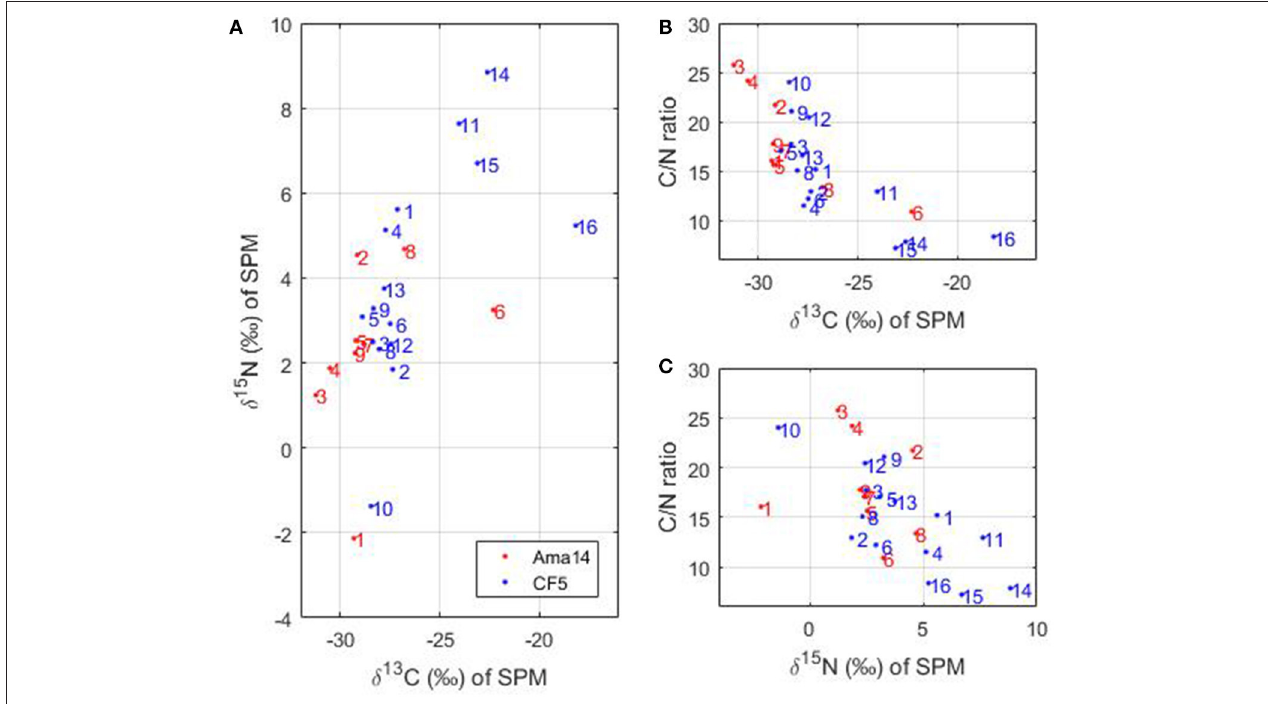
FIGURE 8 | (A) δ 15 N as a function of δ 13 C, (B) C/N ratio as a function of δ 13 C and (C) C/N ratio as a function of δ 15 N measured during the transect in May 2014 (in red) and the Camadas Finas cruise (in blue). The numbers correspond to the stations of the cruises.